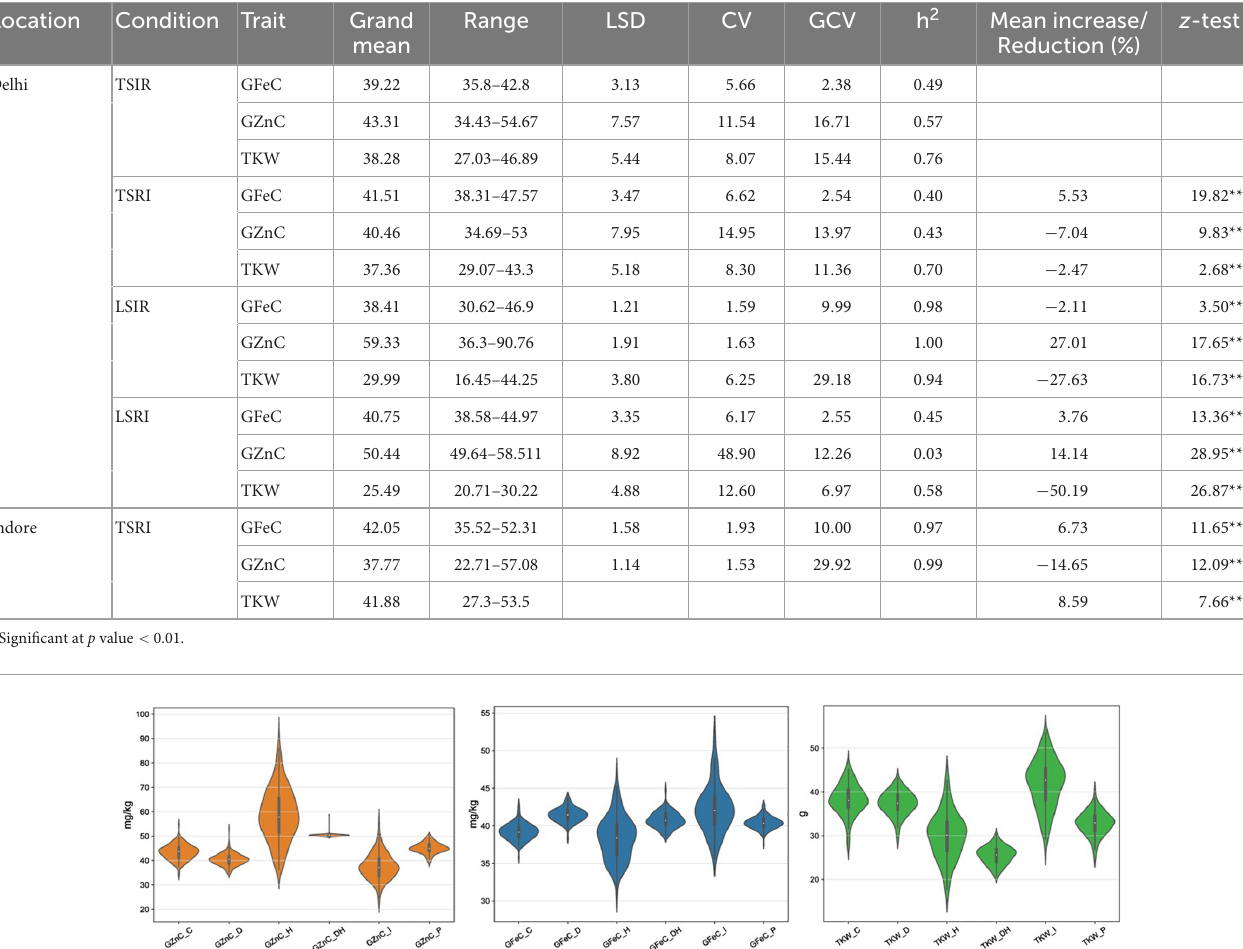
The mean decrease in TKW and increase in GFeC and GZnC was found significant ( p -value of 0.05) using one tailed and two tailed z -test ( Table 3 ). Analysis of variance showed significant variation among the RILs for the traits GFeC, GZnC, and TKW in all the conditions viz ., control (TSIR), drought (TSRI), heat (LSIR), and combined stress (LSRI) in Delhi and drought stress (TSRI) in